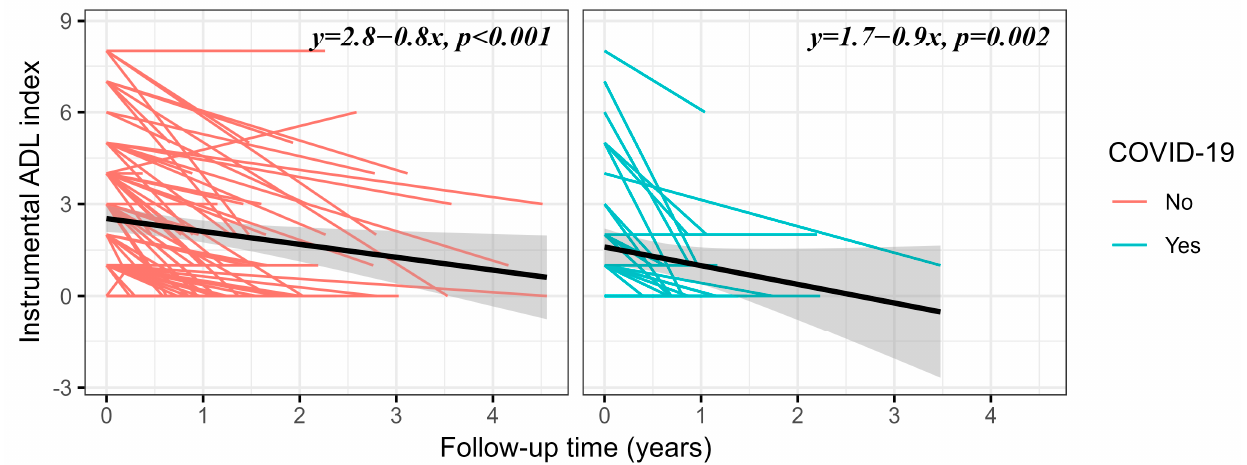
Figure 4. Changes between baseline and follow-up visits of MMSE score, BADL index, and IADL index over time with the summary regression line (black continuous line) and 95% confidence in- terval (gray bands) of patients who had (cyan lines) or did not have (pink lines) COVID-19. In the top right of each rectangle, the equation of the linear regression line is reported with the p -statistic of the